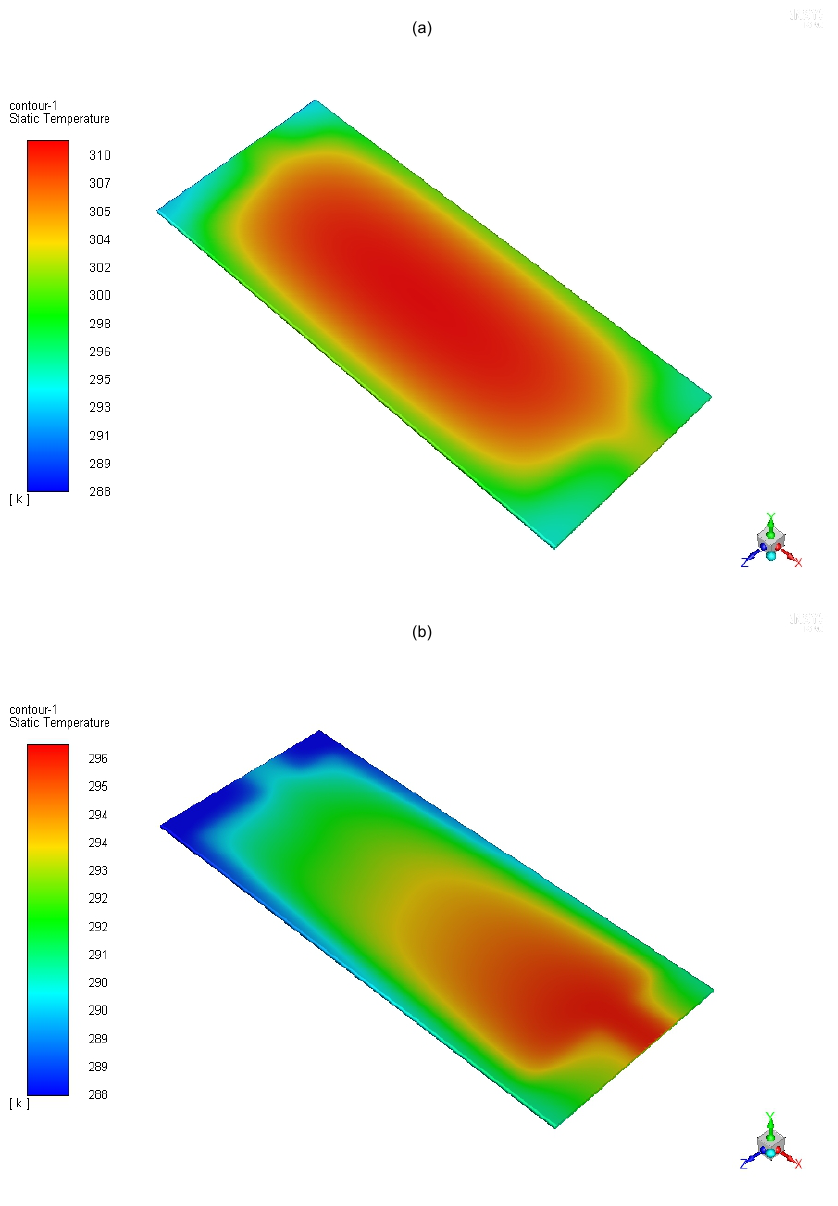
Figure 4. Spatial distribution of the cell temperature when ˙ v = 0 ( a ) and 1000 L/h ( b ). Simulations were performed during an average day of July in Catania (Southern Italy), with orientation SOUTH and tilt 33 ◦ . z − and y − axes are swapped in CFD